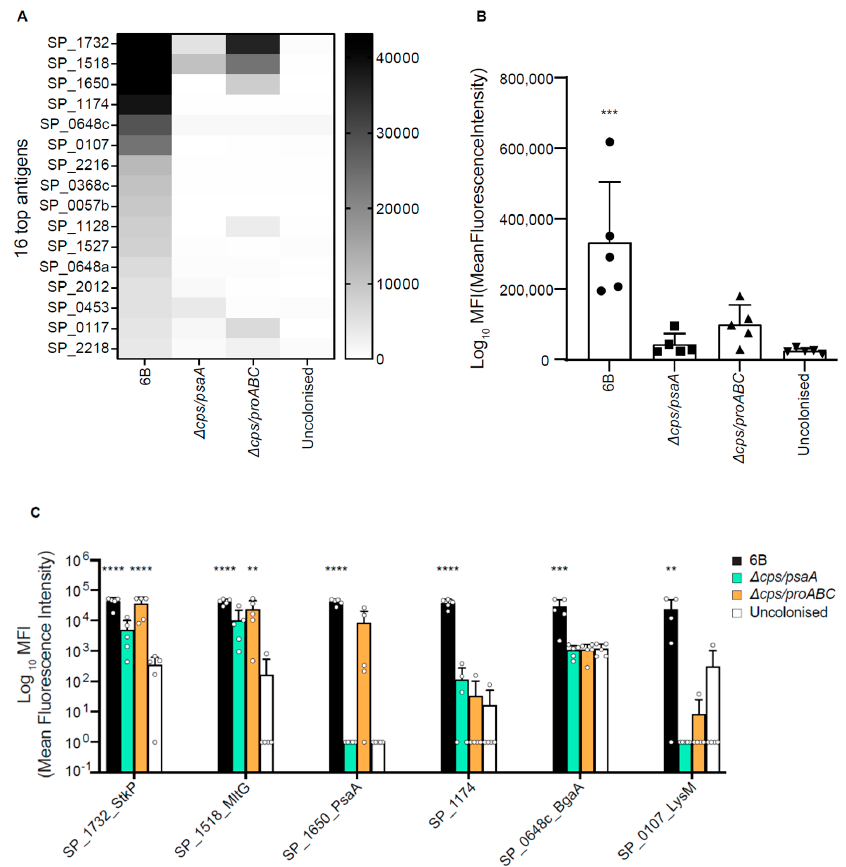
Figure 5. Identification of the protein antigens recognized by IgG in serum from mice colonised with wild type and double mutant S. pneumoniae strains. Antigen specific IgG binding data obtained by probing a protein array containing 254 S. pneumoniae protein antigens with sera from mice colonised twice with the 6B, ∆ cps/psaA , or ∆ cps/proABC strains. ( A ) Heatmap of mean IgG binding levels to